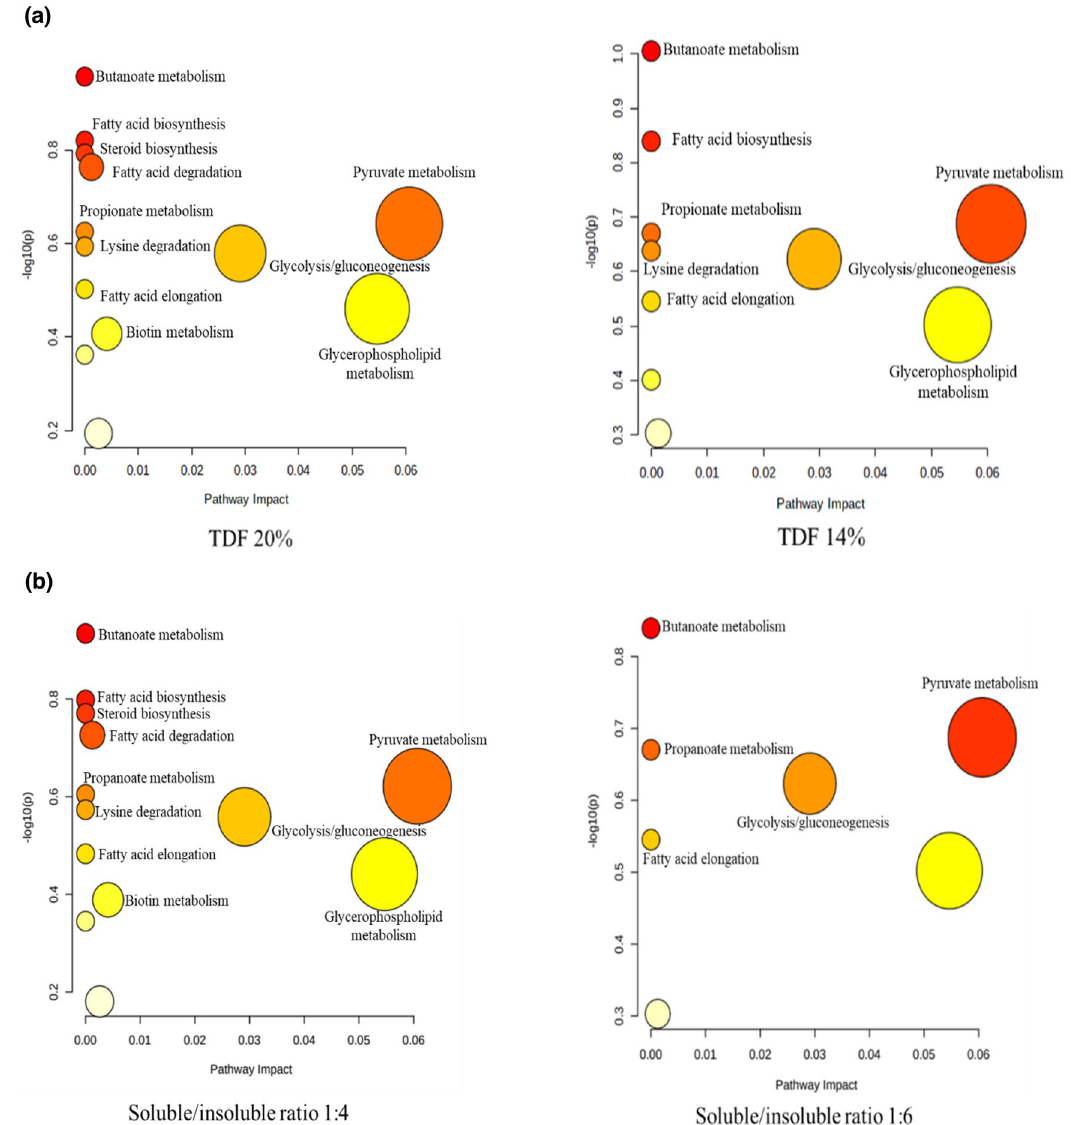
Figure 4 . Effect of dietary fiber levels and soluble to insoluble dietary fiber ratio on metabolome view map of the differential metabolites (variable importance projection > 1, P < 0.05) identified in the feces of sows during late gestation. ( a ) 20% vs. 14% dietary fiber level; ( b ) 1:4 vs. 1:6 soluble to insoluble ratio. The x-axis represents the pathway impact, and the y-axis represents the pathway enrichment. The node color is based on its P-value, and the node radius is determined based on the pathway impact values. Larger sizes and darker colors represent higher pathway enrichment and impact values,